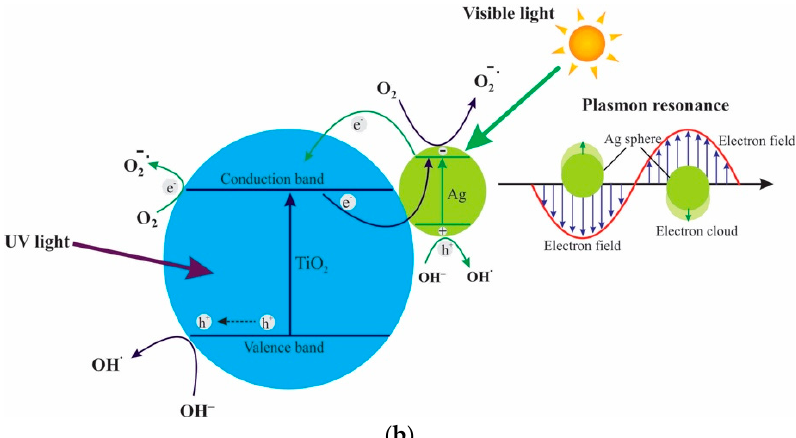
Figure 2. ( a ) UV-Visible spectra of TiO 2 and Ag/TiO 2 as pressed disks . Inset shows the material absorption magnification at 400–700 n; ( b ) surface plasmon resonance (SPR) effect of Ag species deposited on TiO 2 surface, modified from reference [48].